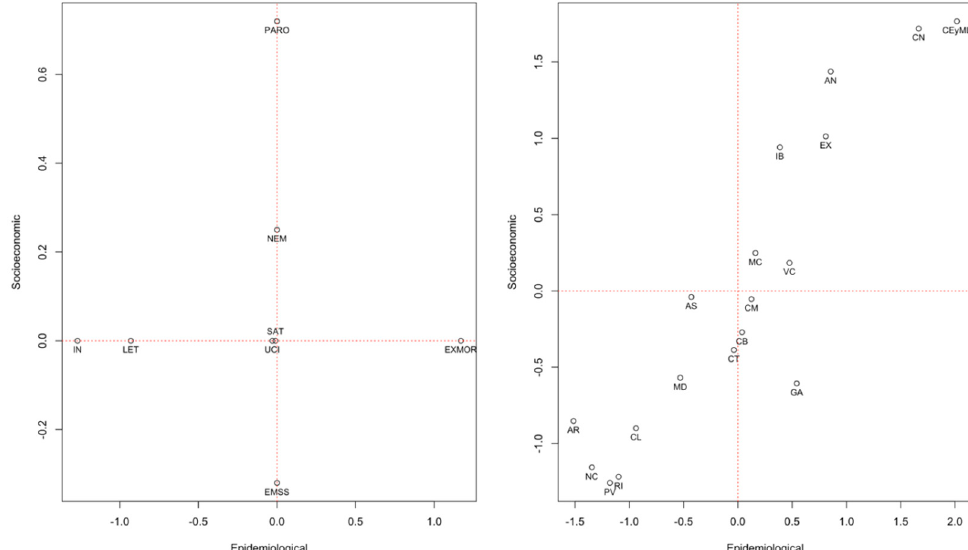
Figure 1. Graphical representation of the canonical correlations of the socioeconomic